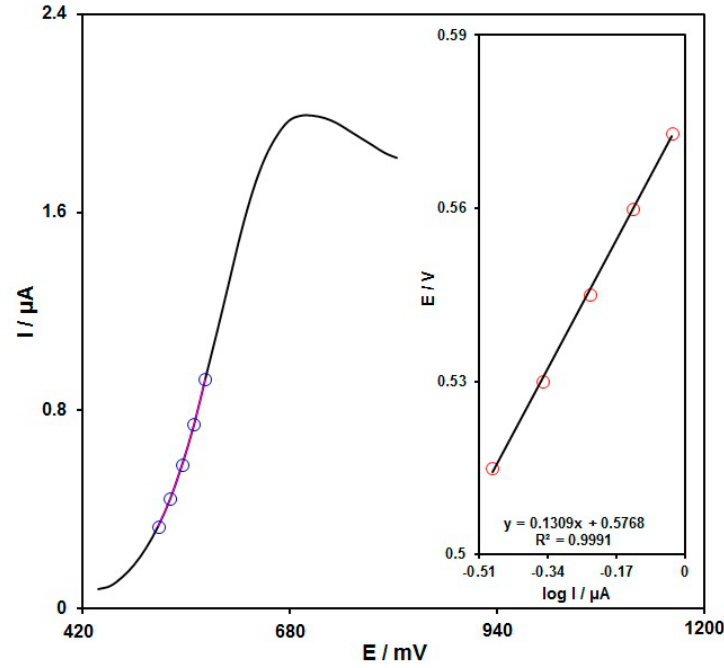
Figure 9. LSV for sunset yellow (60.0 µM) at the scan rate of 10 mV/s. Inset: The Tafel plot from the rising domain of the respective voltammogram. 3.6. Chronoamperometric Analysis Chronoamperometry was used to explore the sunset yellow catalytic oxidation on the NiCo 2 O 4 /SPGE surface. Chronoamperometric analysis was done for variable sunset yellow contents on NiCo 2 O 4 /SPGE at the working electrode potential of 740 mV. The chronoamperograms captured for variable sunset yellow contents on the NiCo 2 O 4 /SPGE can be seen in Figure 10. Cottrell’s equation explains the current (I) for electrochemical reaction of an electroactive material with a D value (diffusion coefficient) under a mass transport-limited condition. Figure 10A shows a linear relationship of the I value with t − 12 for the oxidation of variable sunset yellow contents. The slopes from the obtained straight lines were plotted against variable sunset yellow contents (Figure 10B). The plotted slope and Cottrell equation ( I = nFAD 1/2 C b π − 1/2 t − 1/2 ) estimated the D value to be 9.2 × 10 − 5 cm 2 /s for sunset yellow. The mean D value in this work is comparable with the re- sults published in other papers [73,74].